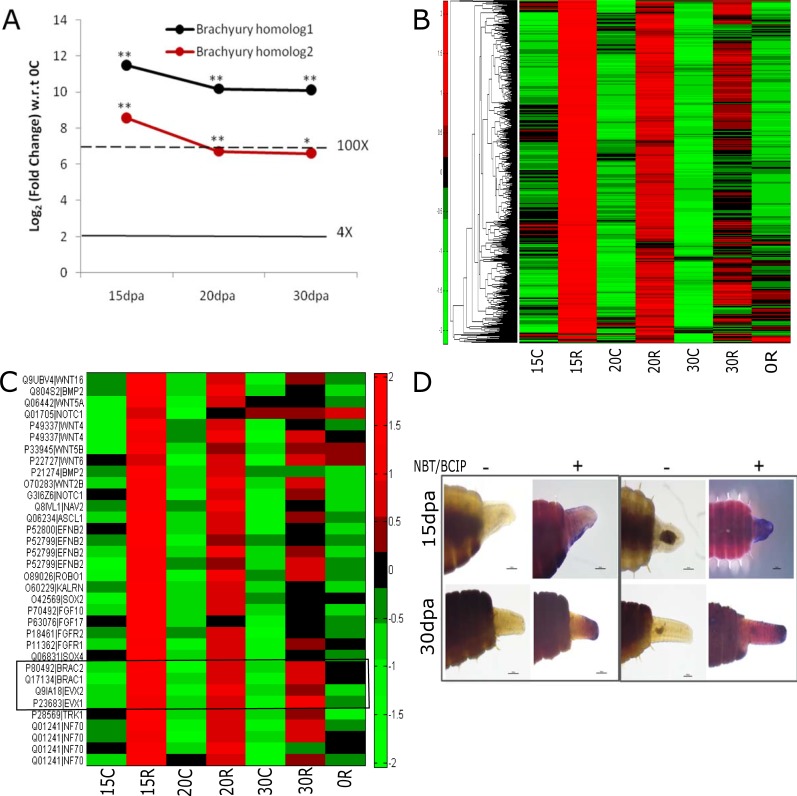
Genes induced in regenerating tissue of E. fetida.(A) Brachyury is the most highly induced gene in the regenerating tissue. The two E. fetida homologs of Branchiostoma floridae (lancelet) Brachyury gene are shown in black and red. * Adjusted pVal<0.05; **Adjusted pVal<0.005. (B) Cluster of 951 genes that match the profile of Brachyury in k-means clustering (C) Expression pattern of developmental genes that are highly induced in the regenerating tissue. Grey box shows Brachyury and Even-skipped. (D) SOX4 is induced in regenerating tissue at 15dpa and 30dpa. Control (probed with sense probe; left panels 1 and 2) and anti-sense probe (right panels) before (-) and after (+) addition of chromogenic agent (NBT/BCIP).